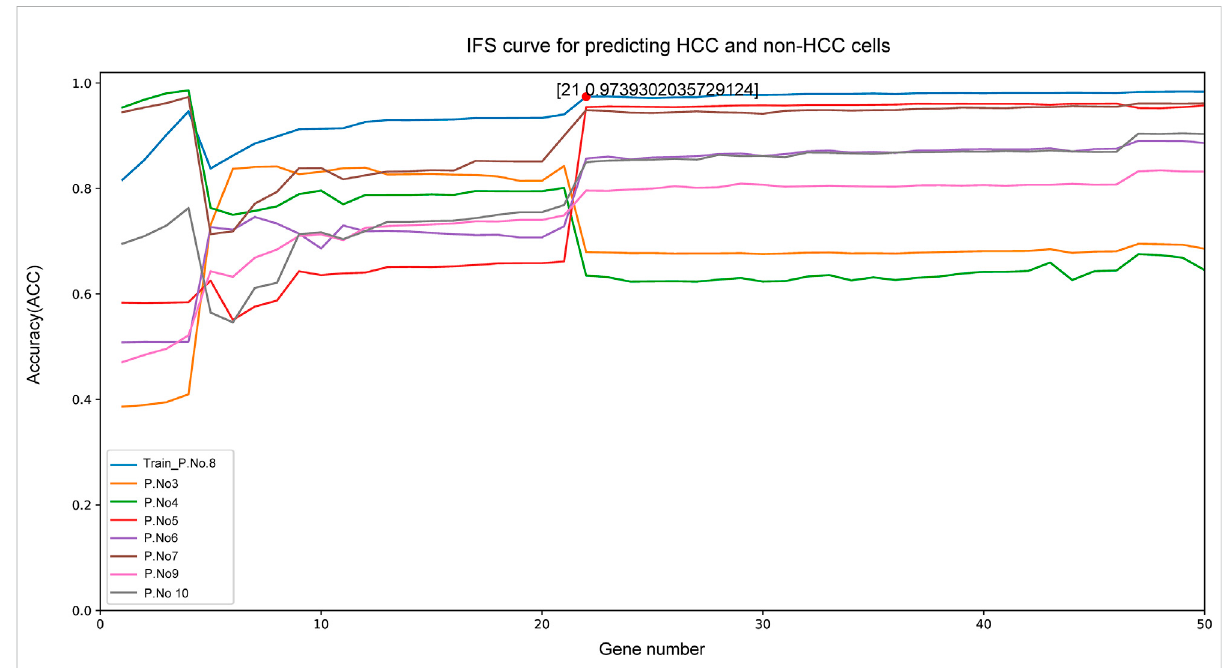
FIGURE 2 TheIFScurveofthetop50mRMRgenes.The x -axiswastheincludednumberoftopgenesandthe y -axiswasthepredictionperformance.The blueplotwasthetrainingsetfrompatientNO.8.ThepeakMCCwas0.974whentop21genesincludedtoIFSmodel.These21geneswerechosenas the optimal HCC biomarkers.